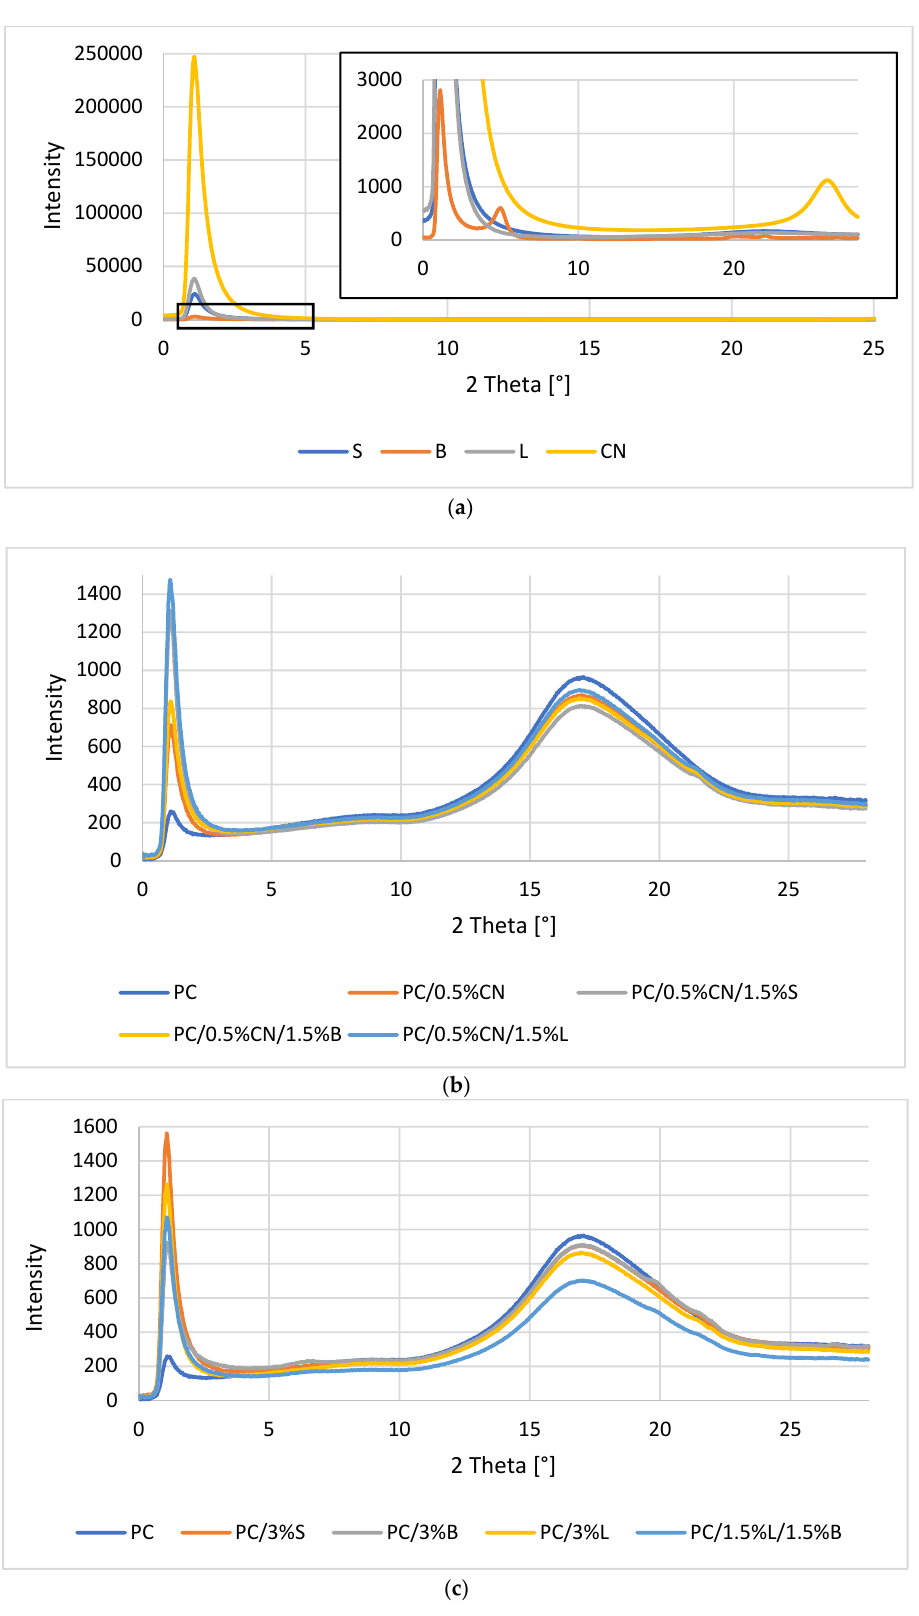
Figure 12. WAXS patterns: ( a ) fillers; ( b ) PC and composites with the addition of modified S, B, L and CN fillers; ( c ) PC and composites with the addition of modified fillers S, B and L.